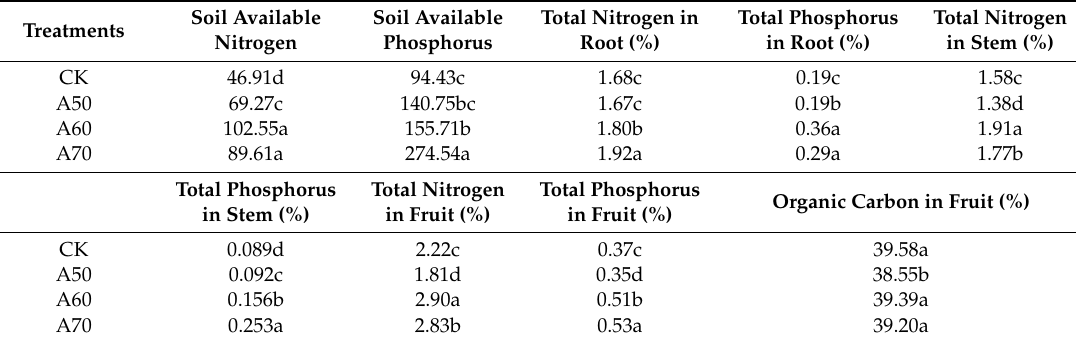
Table 6. Soil nutrient and tomato growth indexes.